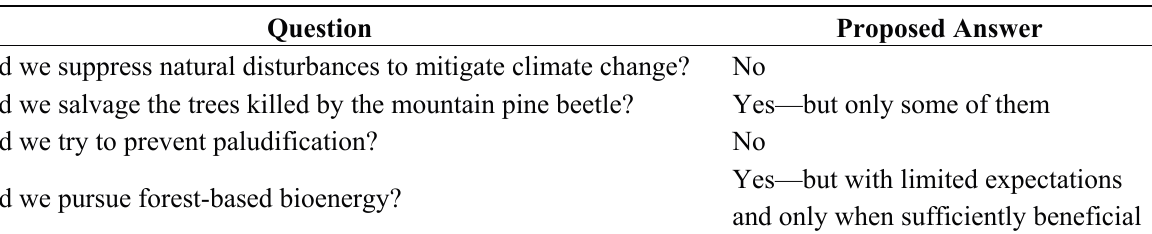
Table 2. Proposed answers to questions of current interest in Canadian managed forests, based on the five scientific principles listed in Table